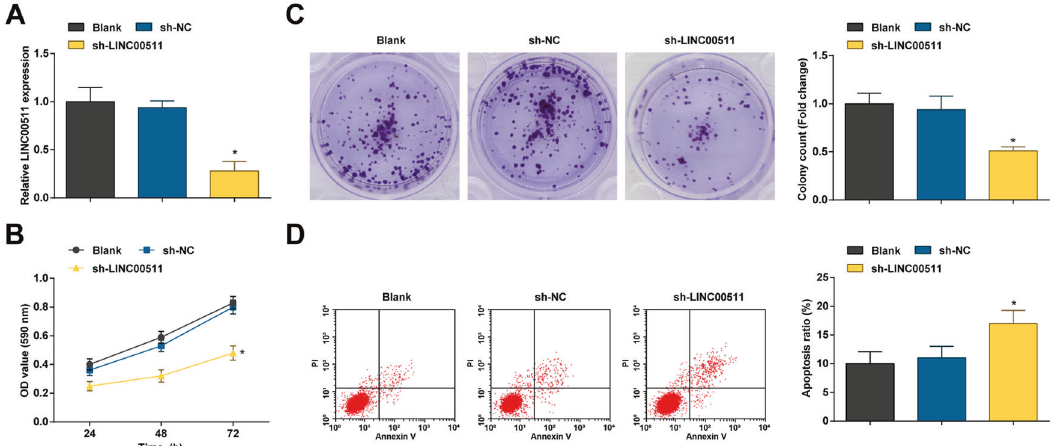
Fig. 2 LINC00511 knockdown destroys CC cell viability and colony forming ability and encourages apoptosis. A RT-qPCR detected LINC00511 expression in CC cells; B MTT assay detected viability of CC cells; C colony formation assay detected colony-forming ability of CC cells; D Flow cytometry detected apoptosis rate of CC cells; the measurement data are expressed as mean ± standard deviation. N = 3. * P < 0.05 compared with the sh-NC